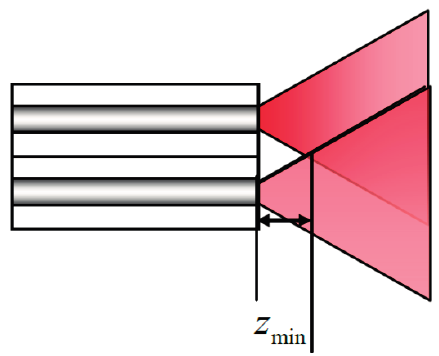
Figure 6. Minimum distance between optical fiber ends and observation